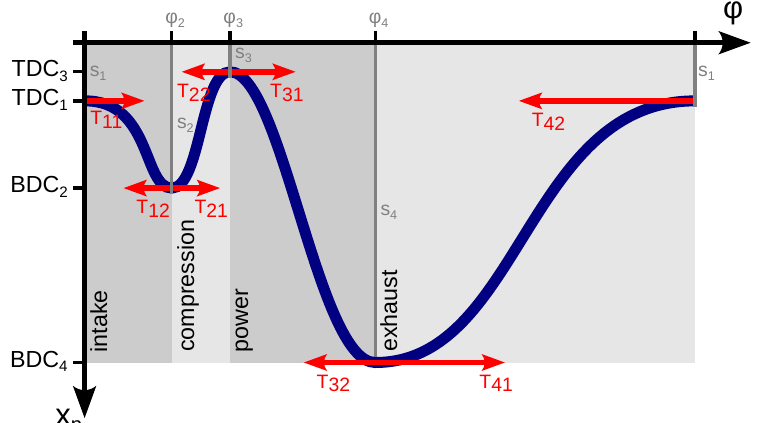
Figure 2. Parameters of the 4 cubic Hermite spline functions that combine to the adjustable piston